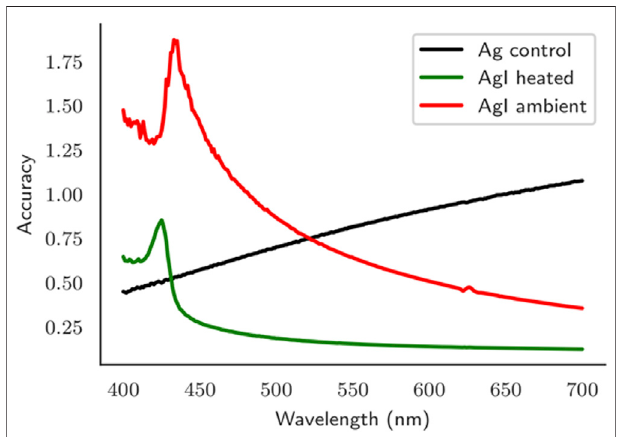
FIGURE 4 | UV-Vis spectra of silver thin fi lms before and after iodization under ambient ( λ max (cid:2) 433 nm) and heated to 30 ° C ( λ max (cid:2) 424 nm). The presence of surface plasmon resonance in the blank silver samples suggests the thin fi lms are discontinuous small islands of metal formed during the sputtering process.